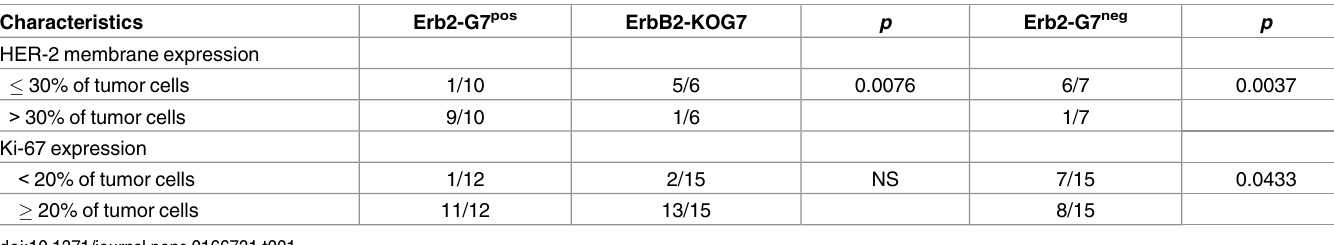
Table 1. Comparison between ErbB2 tumors induced in the presence or absence of gal-7 in mice.